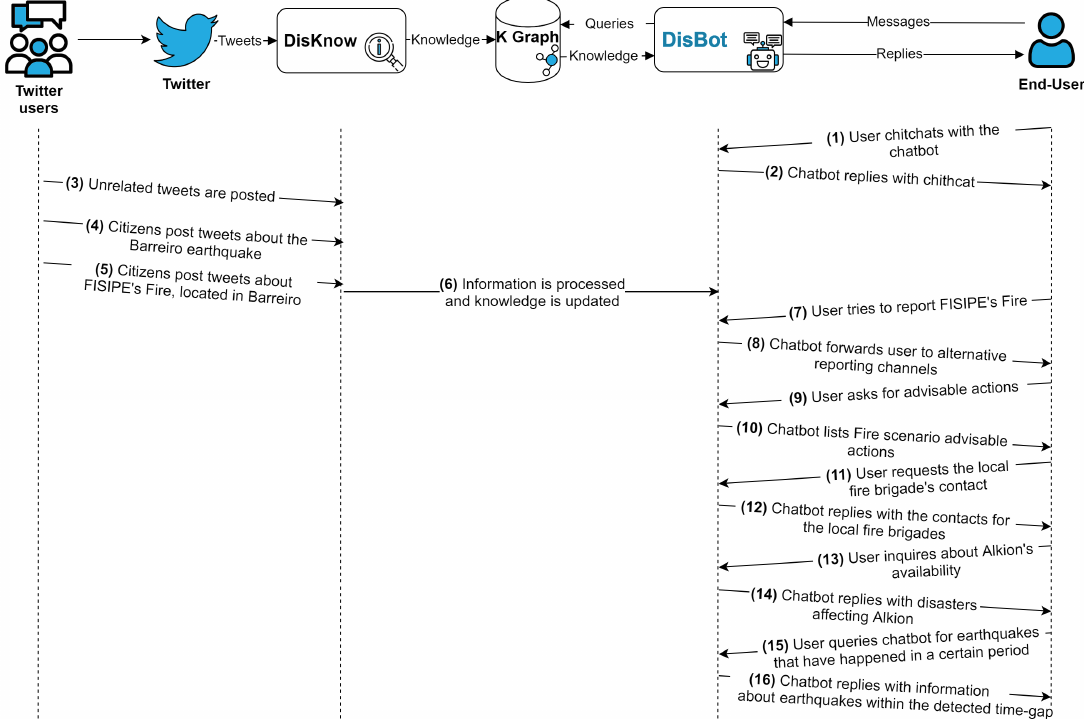
Figure 5. Demonstration use-case